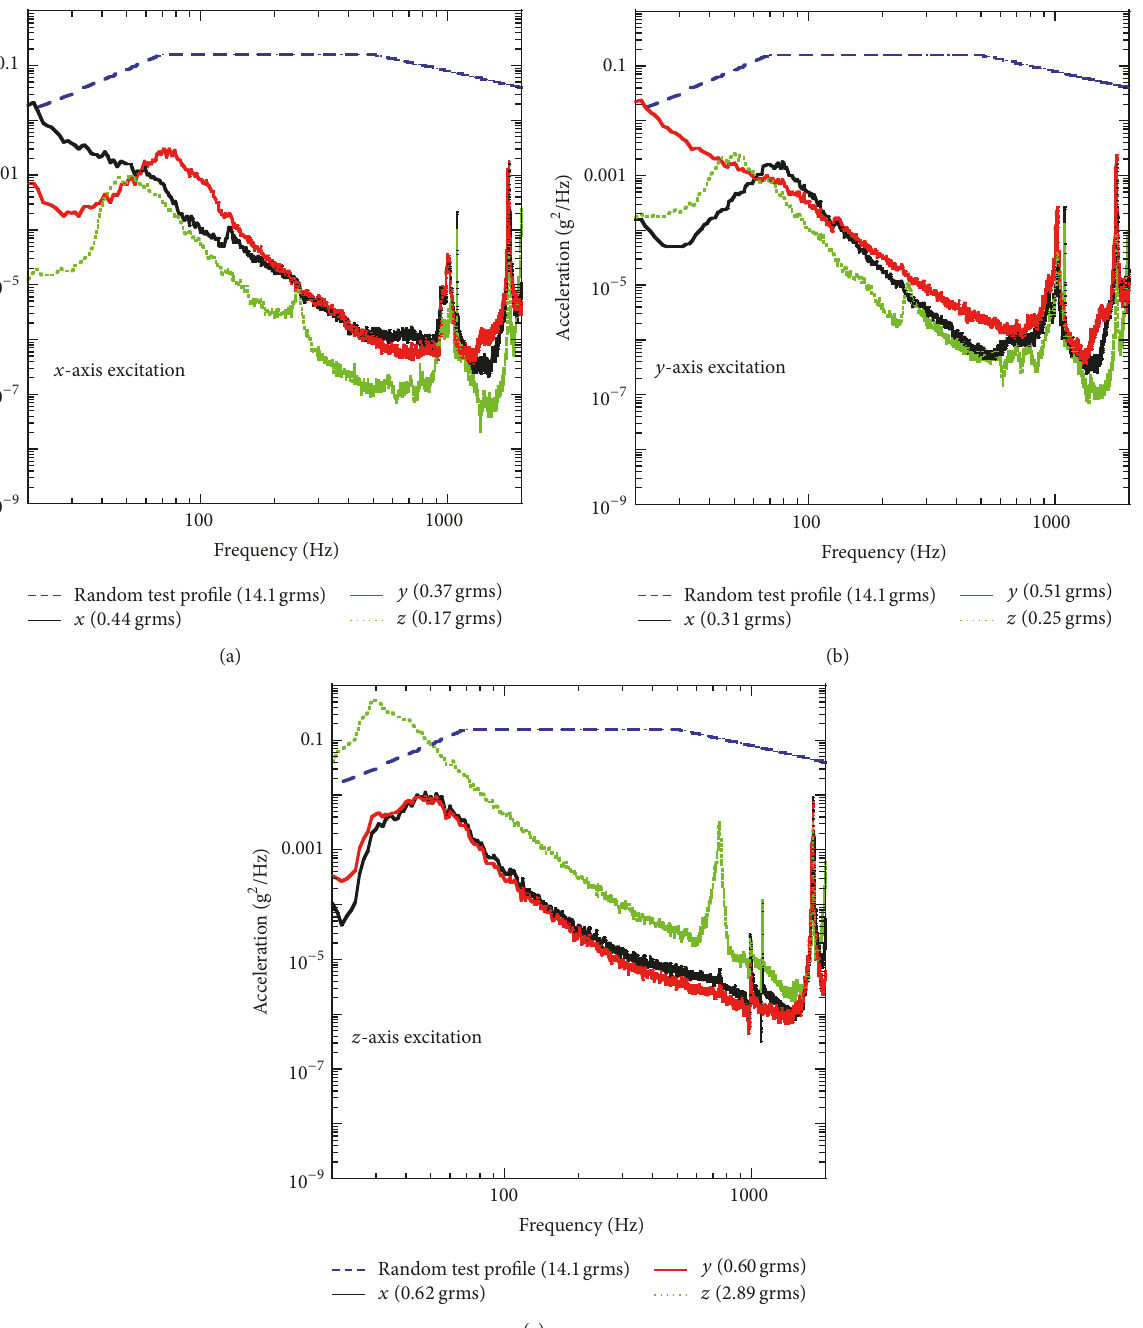
Figure 10: Results for random vibration tests of the RWA isolation system with respect to each axis excitation ((a): 𝑥 -axis, (b): 𝑦 -axis, and (c): 𝑧